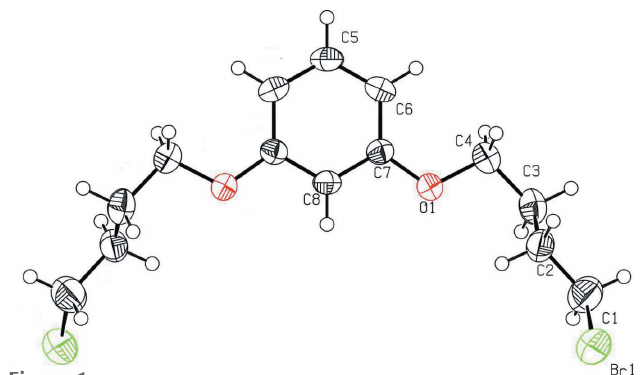
Figure 1 The molecular structure of the title compound, with the atom labelling. Displacement ellipsoids are drawn at the 50% probability level. Unlabelled atoms are related to the labelled atoms by the twofold rotation axis (symmetry code: (cid:4) x + 1, y , (cid:4) z + 1 C8.